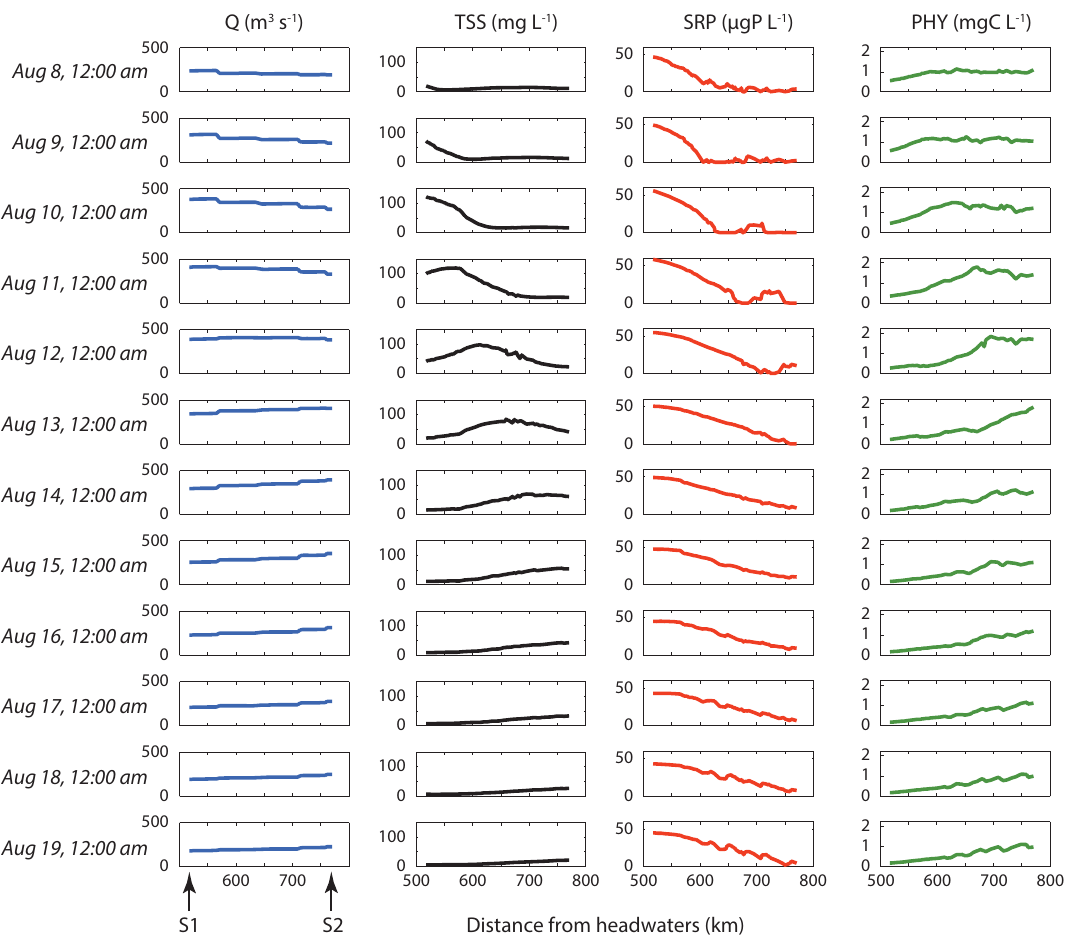
Figure 6. Longitudinal evolution of discharge Q , TSS, SRP and PHY concentrations when a storm event occurred between 8 and 19 August